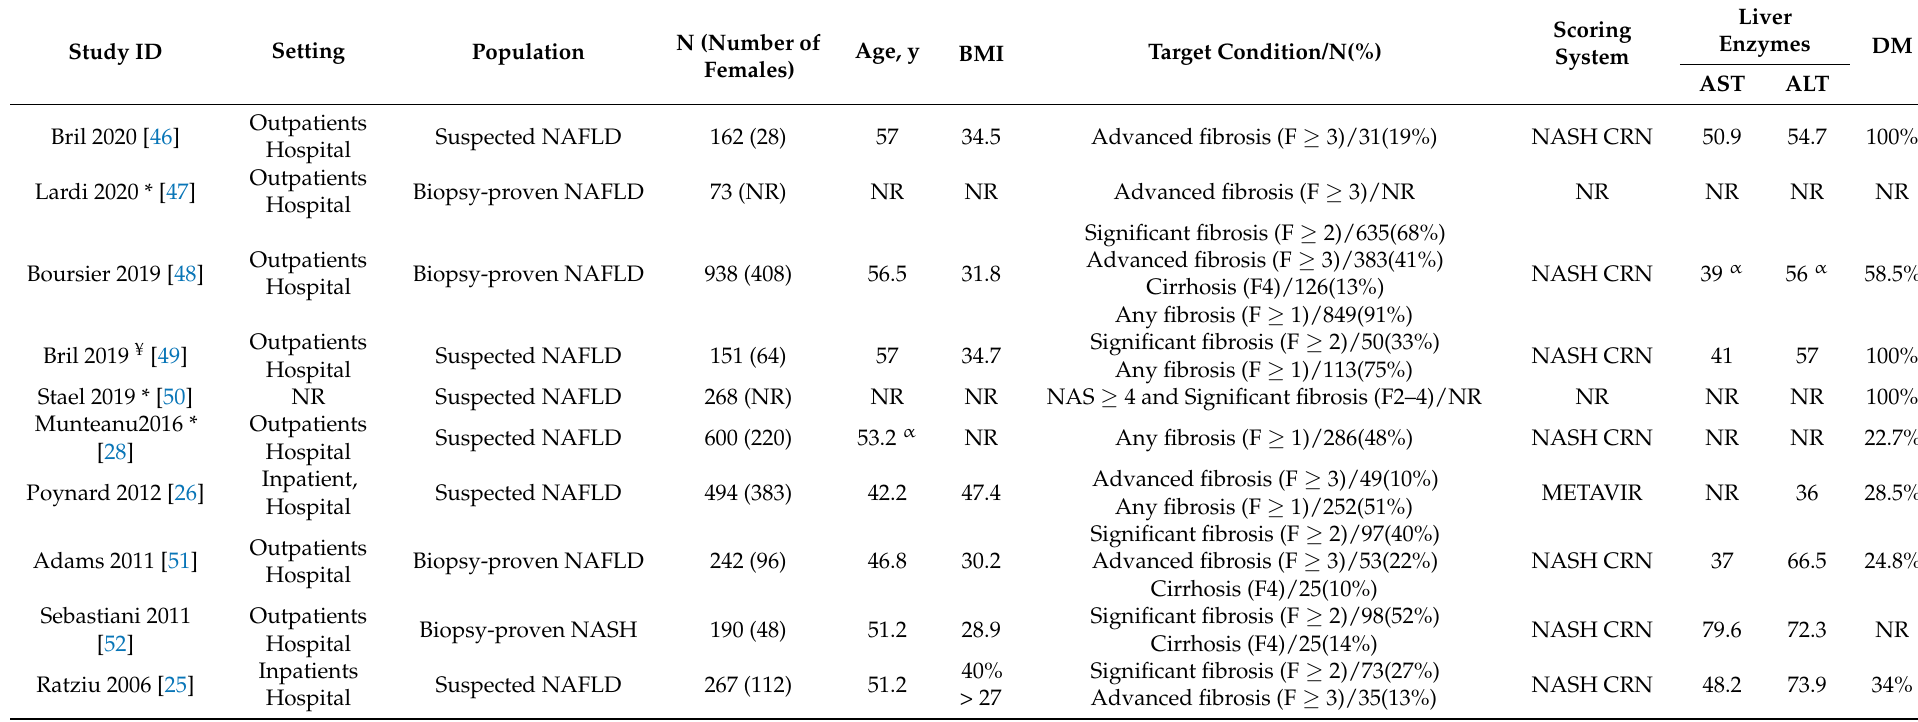
Table 1. Major characteristics of the 10 studies